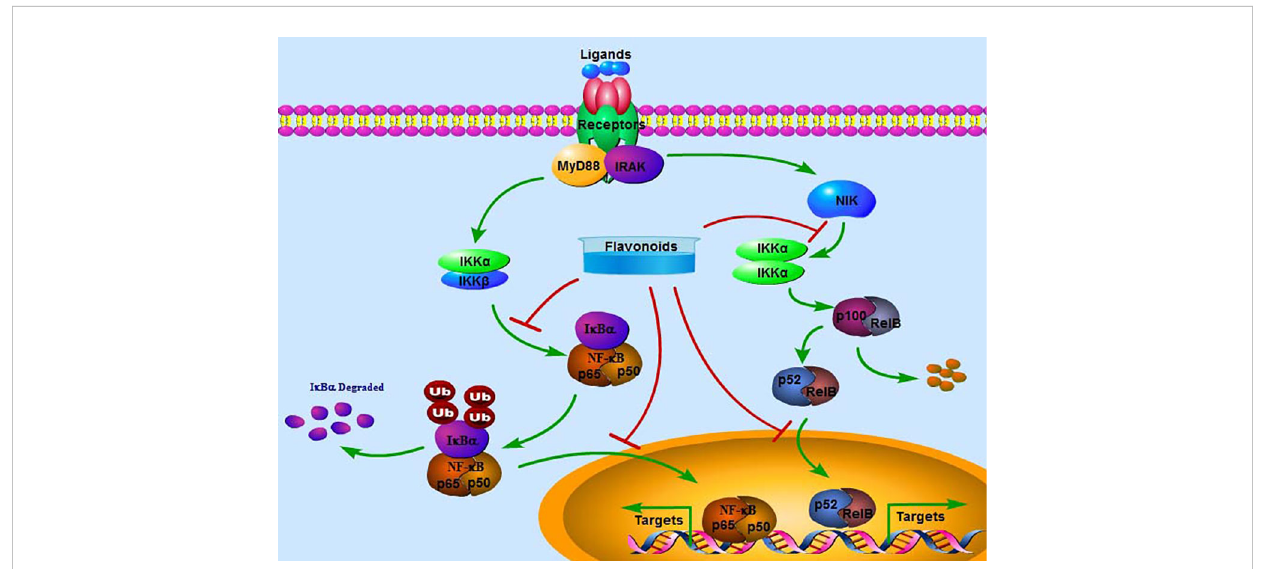
FIGURE 2 The classical signaling pathway of NF- k B. Extracellular ligands can activate the NF- k B pathway by interacting with the receptor, which activates and phosphorylates IKK a / b . Activated IKK a / b may phosphorylate and degrade I k B a , releasing p65 and p50. The complex p65/p50 enters the nucleus to transcriptionally regulate the expression of target genes. Alternatively, NIK-activated IKK a / a can further stimulate p100 to be processed into p52, which forms a complex with RelB and then enters the nucleus to transcriptionally regulate the expression of target genes. Flavonoids may inactivate the NF- k B pathway by inhibiting the phosphorylation of IKK a / b and I k B a , the nuclear translocation of p65/p50 and p52/RelB and suppressing the expression of target